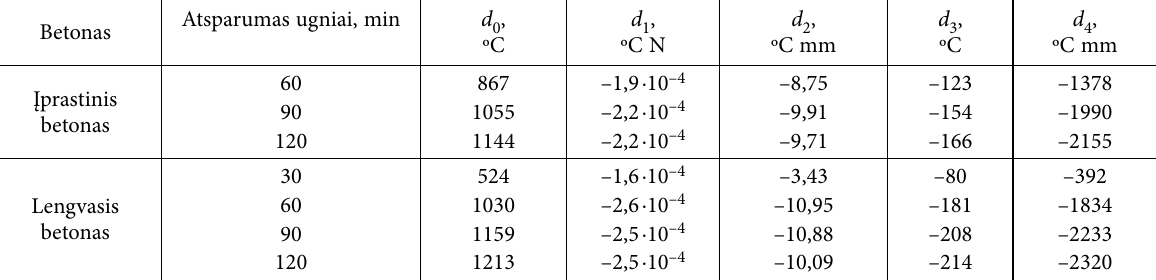
Table 4. Coefficients for design of limitary temperature